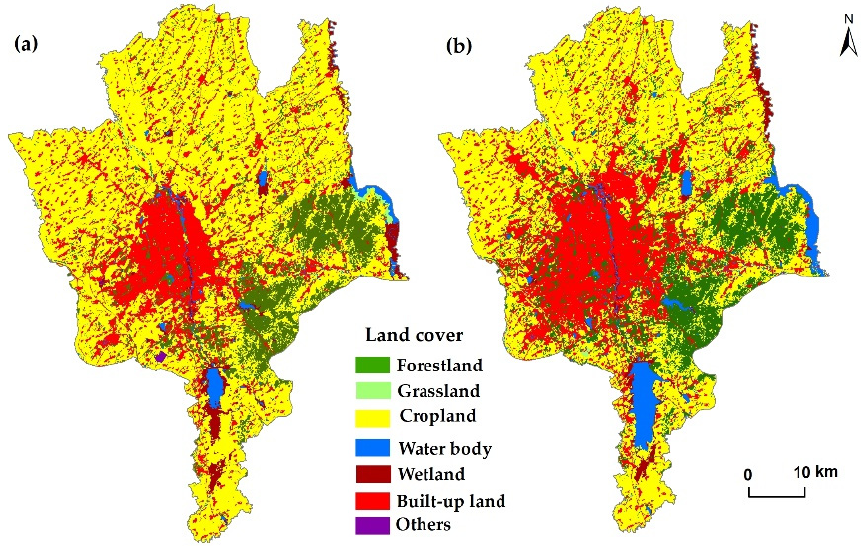
Figure 7. Land cover of Changchun in ( a ) 2005, and in ( b ) 2015.